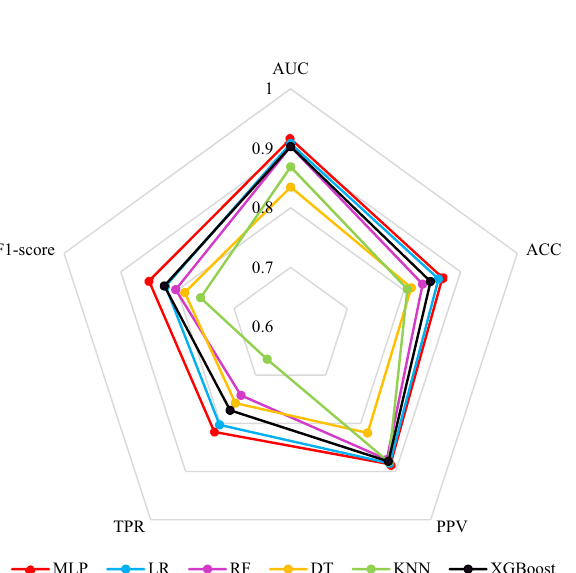
Figure 7. Comparison of each model when cut-off was 0.5. MLP (neural network model), LR (Logistic Regression), RF (Random Forest), DT (Decision Tree), KNN ( k -Nearest Neighbor), XGBoost (eXtreme gradient boosting), AUC (area under the receiver operating characteristic curve), ACC (accuracy), PPV (precision, positive predictive value), TPR (recall, true positive